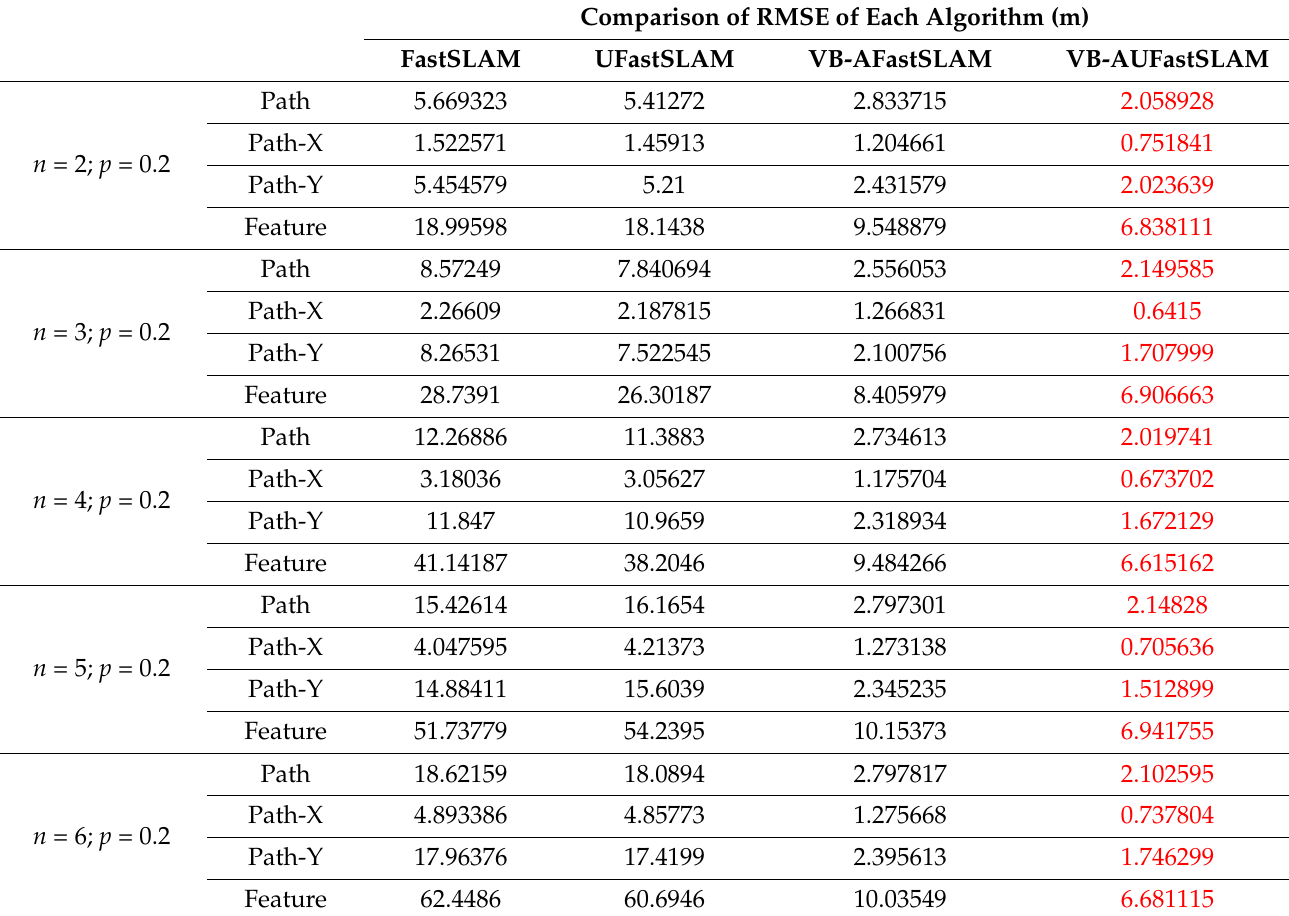
Figure 6. Comparison of Neff with different observation noise. Table 5. p is constant, n